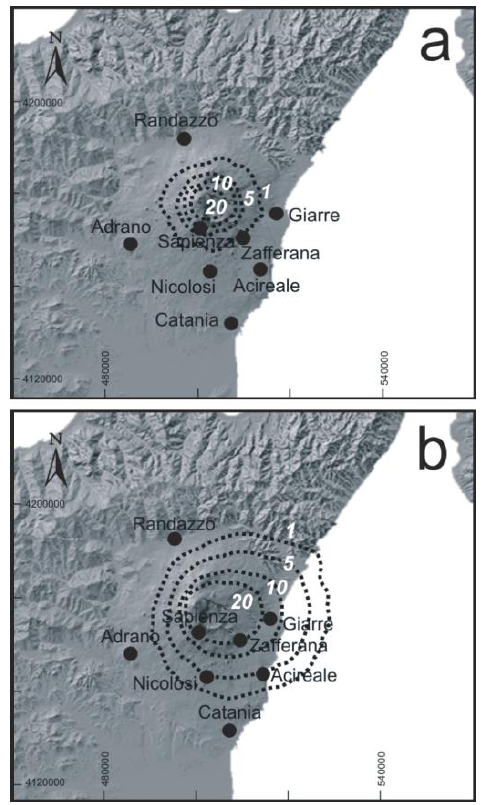
Figure 9. Probability maps for the OES-SSL1 having similar features of 5 January 1990 eruption 666 Fig. 9. Probability maps for the OES-SSL1, having similar fea- tures to the 5 January 1990 eruption, considering thresholds of (a) 100kgm − 2 and (b) 10kgm − 2 .